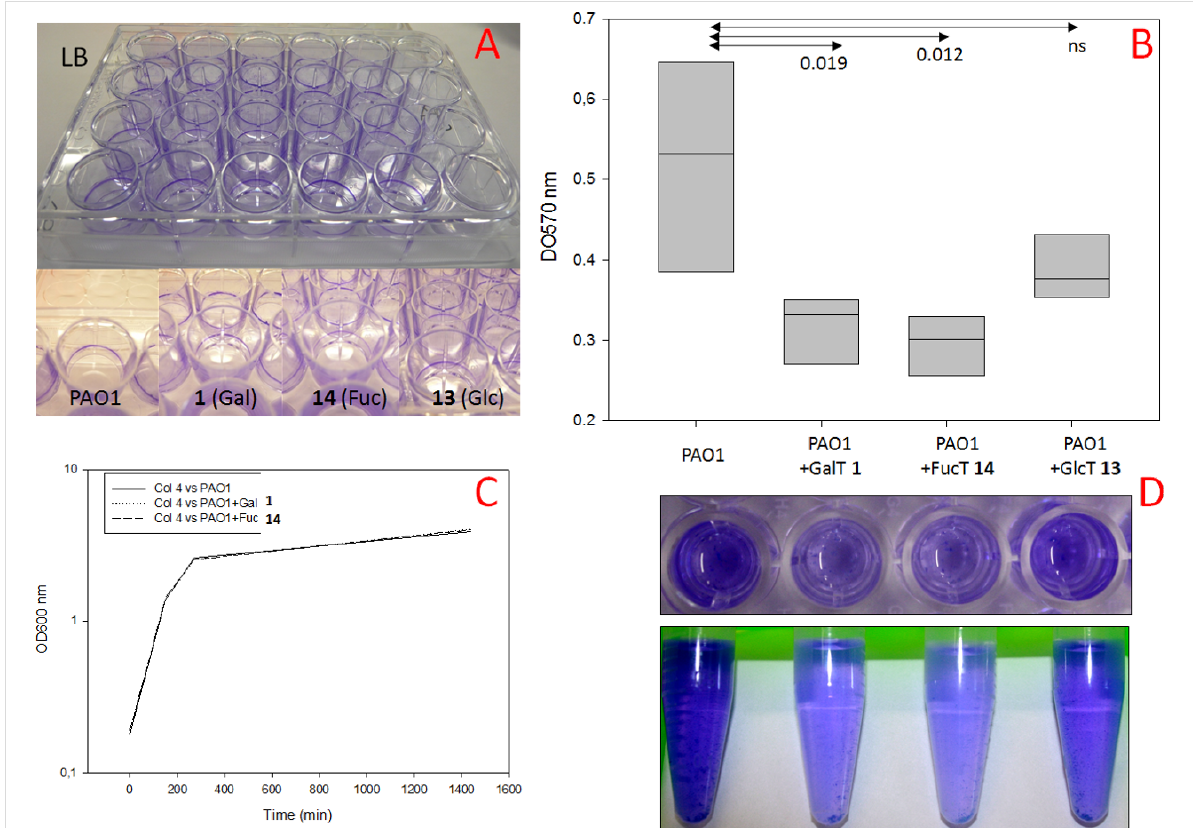
Figure 4: Inhibition of PAO1 biofilm formation by D-galactose cluster 1 , L-fucose cluster 14 , and D-glucose cluster 13 (negative control). A) Biofilm growth assay in LB medium. B) Statistical analysis (above, n = 5, duplicate UV measurements) of ethanol-solubilized biofilm recovered from each well (below). C) PAO1 growth inhibition control